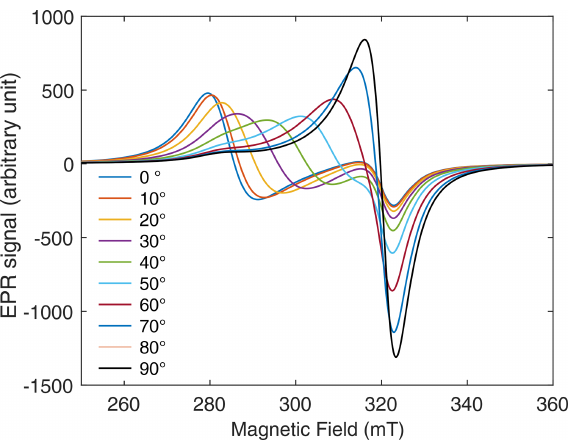
Figure 4. EPR spectra of frozen cuprorivaite grains magnetically oriented in oil for different angles β 0 = ( (cid:92) Z 0 ,Z ) between the orient- ing and measuring fields. The rotation axis is Y 0 , and the sample was set with Y (cid:107) Y 0 .